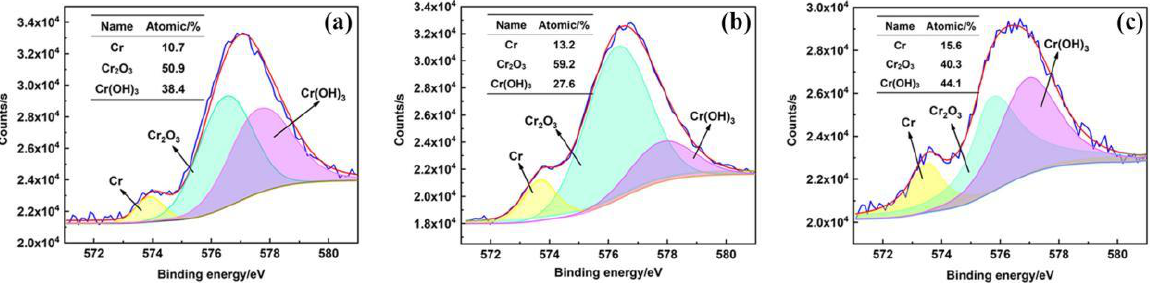
Figure 10. Cr2p peak fitting of 2205 DSS cladding layer under different current. ( a ) 90 A; ( b ) 100 A; ( c )110 A. Figure 11. Fe2p peak fitting of 2205 DSS cladding layer under different current. ( a ) 90 A; ( b ) 100 A; ( c ) 110 A.